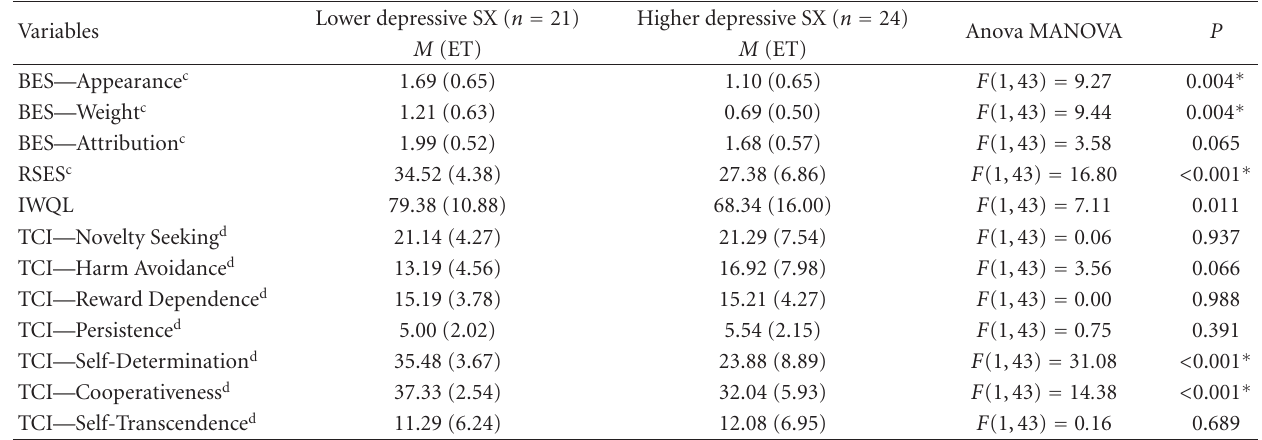
Table 2: Di ff erences between groups for psychological